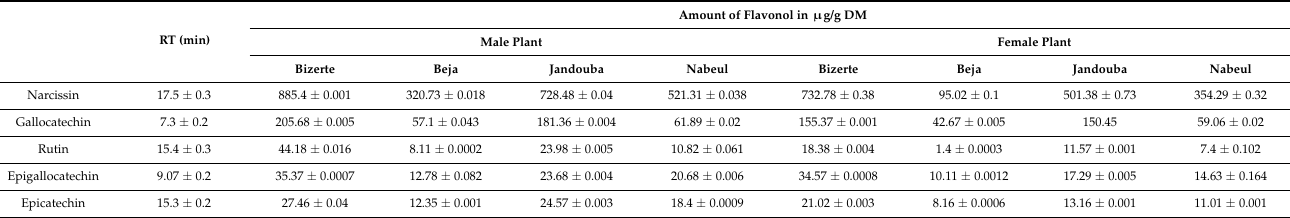
Values shown are mean ± SD ( n = 3).